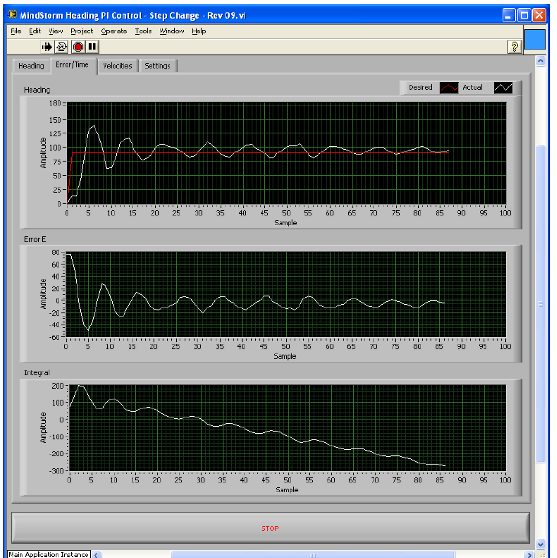
Figure 20. Mindstorm Pose Adjustment Step Responses – Proportional-Only Control